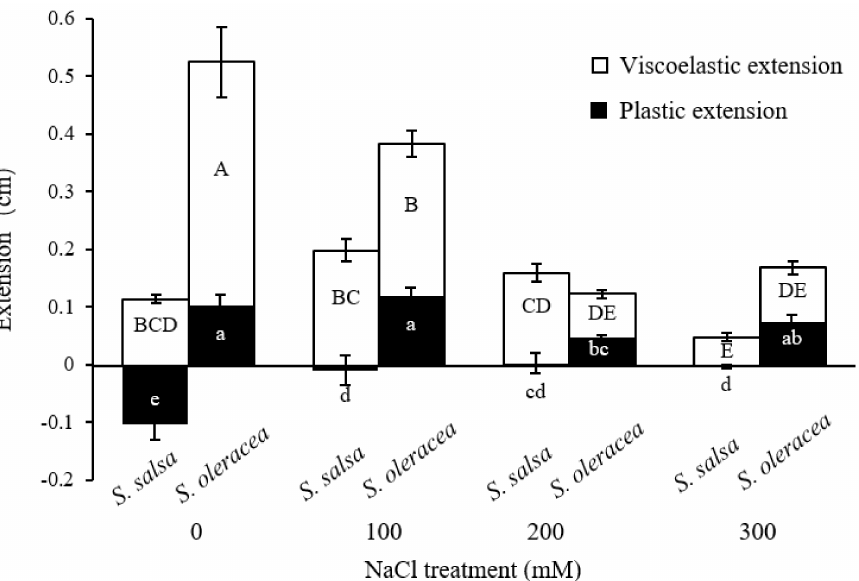
Figure 4. Viscoelastic extension and plastic extension in S. salsa and S. oleracea root grown under 0, 100, 200, and 300 mM NaCl treatments. Data are mean ± S.D. ( n = 12–15). Different uppercase (viscoelastic extension) and lowercase (plastic extension) letters indicate significant differences ( p <